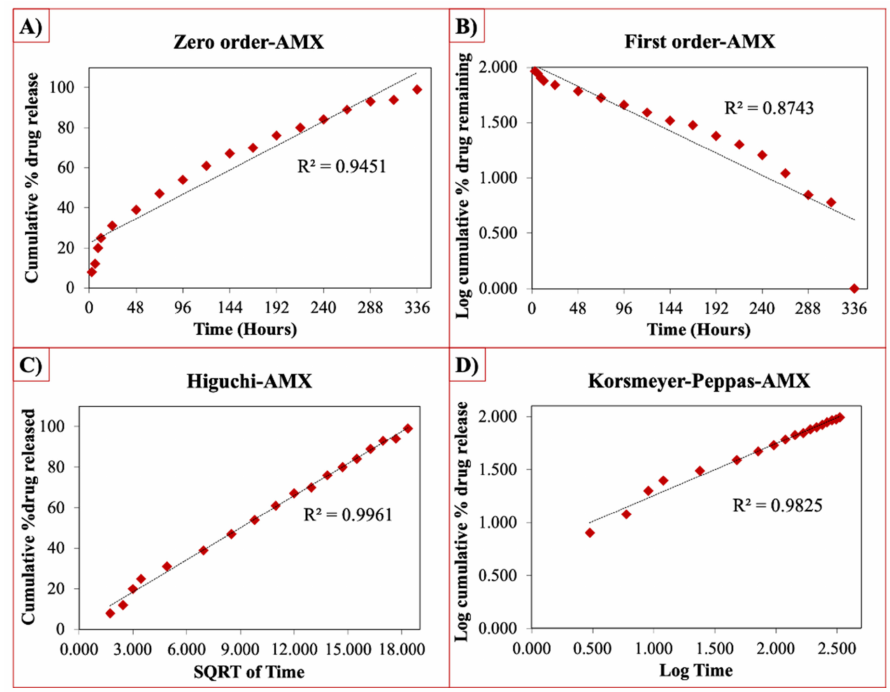
Figure 9. Zero order ( A ), first order ( B ), Higuchi ( C ), Korsmeyer–Peppas ( D ) kinetic releases of BC/PCL+AMX